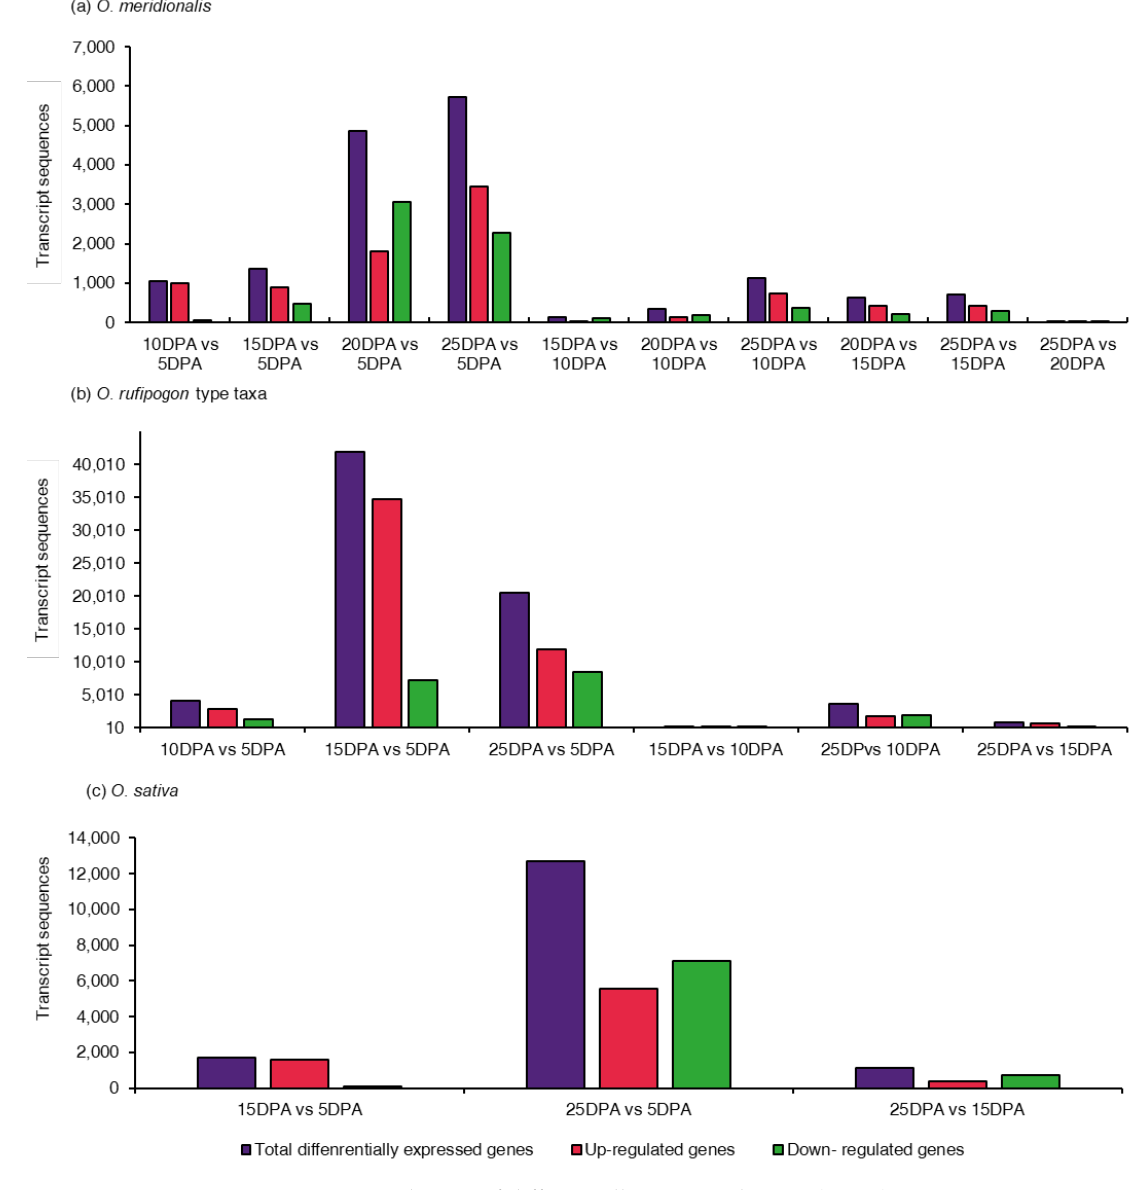
Figure 1. Distribution of differentially expressed genes (DEGs) in comparison groups of the seed developing stages: ( a ) 10 comparison groups from five seed developing stages in O. meridionalis ; ( b ) six comparison groups from four seed developing stages of O. rufipogon type taxa; ( c ) three comparison group from three seed developing stages of O. sativa . The y -axis represents the number of transcript sequences that were significantly differentially expressed at a false discovery rate (FDR) p -value of ≤ 0.01. The x -axis represents comparison groups between seed developing stages at days post anthesis (DPA). DPA on the right side of a comparison group represents a control group.